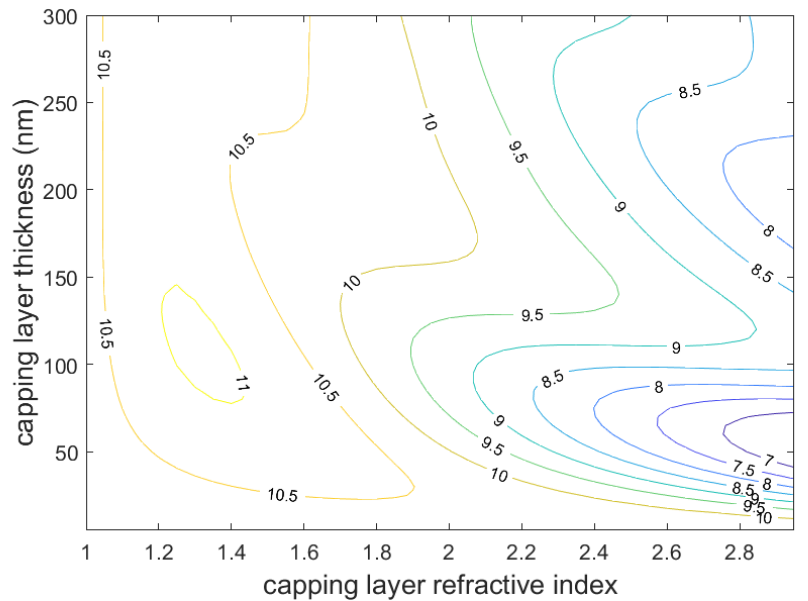
Figure 11. J SC for various values of the refractive index and the thickness of a conceptual top anti-reflection layer.